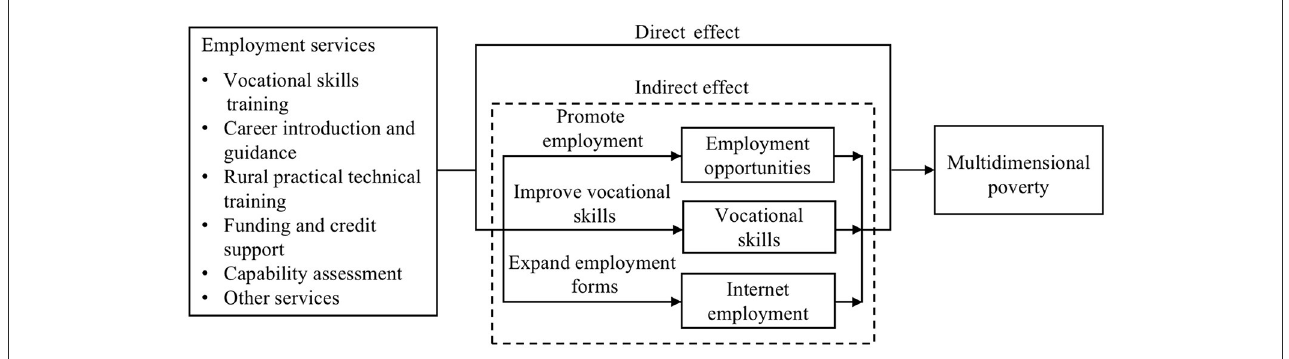
FIGURE1 The mechanism of employment services to improve multidimensional poverty of persons with